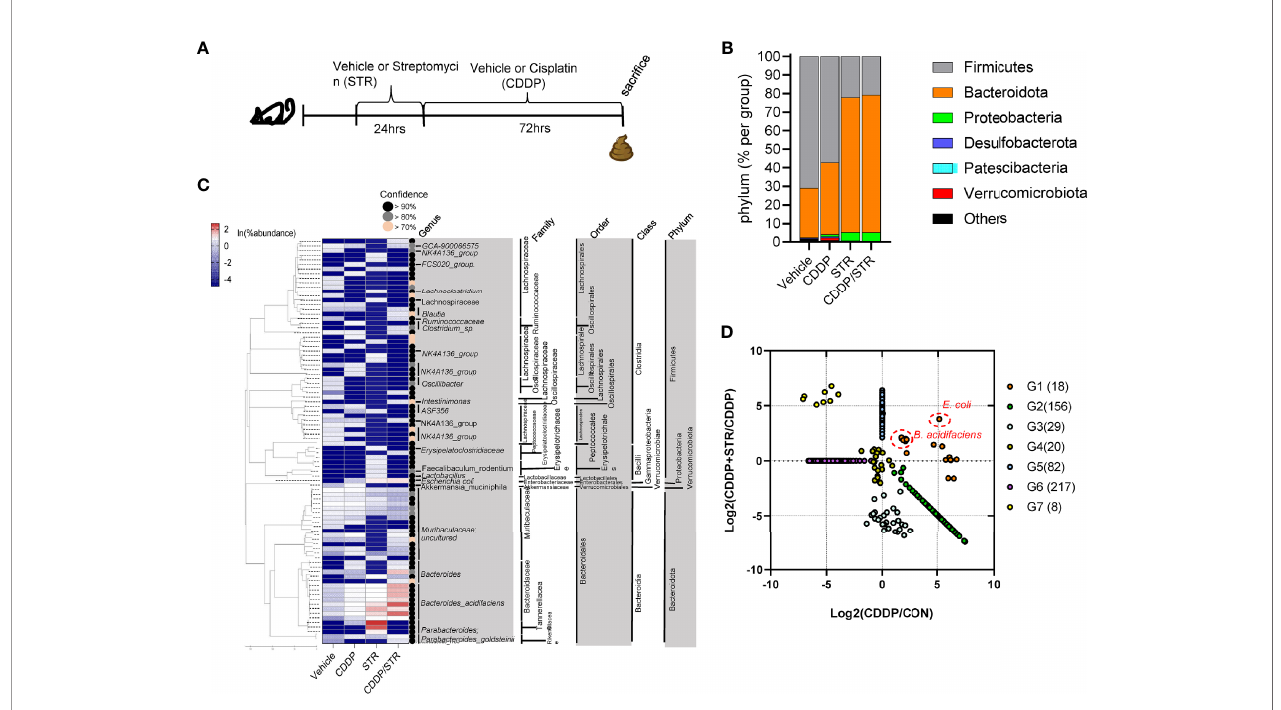
FIGURE 5 | Effects of STR exposure on the murine gut microbiota pro fi le in CDDP-induced renal injury model. (A) Eight-week-old wild type male mice (n = 3 – 5) were orally preexposed to the vehicle or streptomycin (20 mg/mouse) for 24 h and then renal injury was induced with CDDP (20 mg/kg) via intraperitoneal administration for an additional 72 h. (B) The fecal bacteria were subjected to 16S rRNA analysis for phylogenetic composition at the phylum level (B. the mean relative abundances of phyla). (C) The bacteria of each top 30 abundant taxa are listed along with the corresponding mean relative abundance. (D) Relative abundance and clustering of bacterial consortia in response to STR in CDDP-induced renal injury. Results are representative of two independent